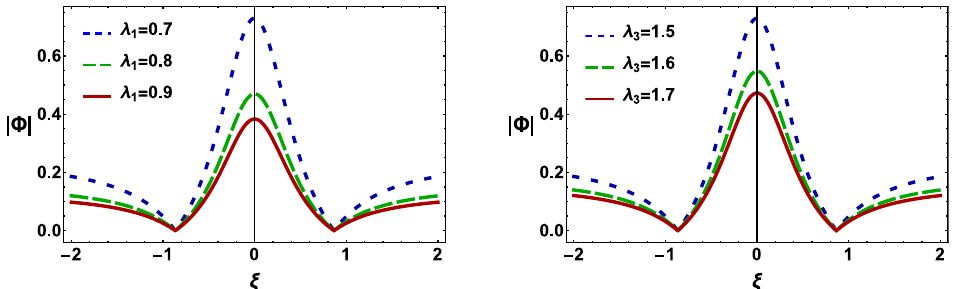
Figure 2. The variation of | Φ | with ξ for different values of λ 1 when λ 3 = 1.5 ( left panel), and the variation of | Φ | with ξ for different values of λ 3 when λ 1 = 0.8 ( right panel). Other plasma parameters are λ 2 = 2.0, λ 4 = 0.4, κ = 1.8, and k =